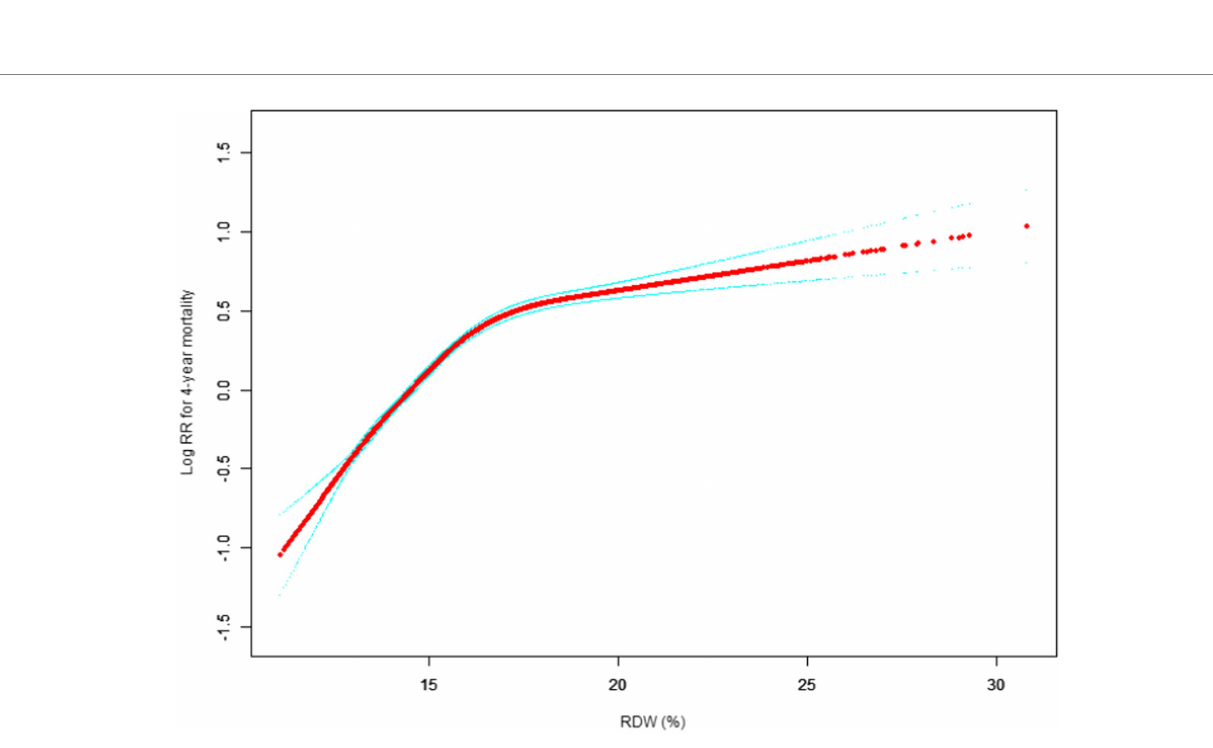
FIGURE 5 Association between RDW and 4-year all-cause mortality. (After adjustment for other covariates). A generalized additive model (GAM) revealed a threshold, nonlinear relationship between RDW and 30-day mortality. The smooth curve fit between variables is shown by a solid red line. The 95% confidence interval from the fit is represented by imaginary blue line.